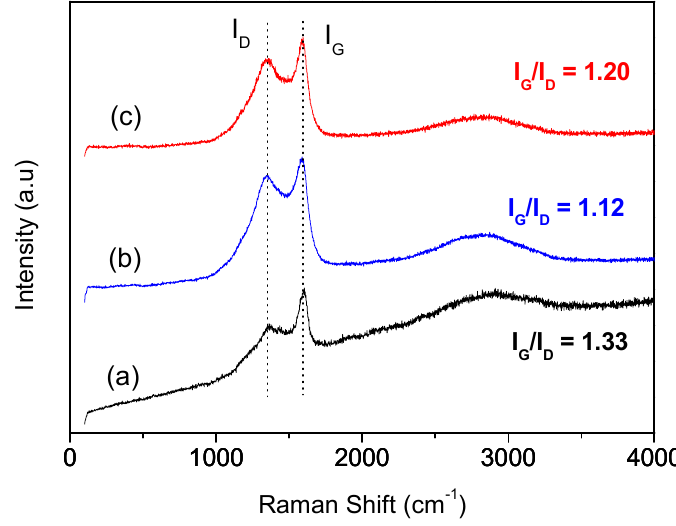
Figure 8. Raman spectra of carbon residue after heat treatment after 15 min at different temperatures: ( a ) 600 °C, ( b ) 800 °C, and ( c ) 1000 °C.